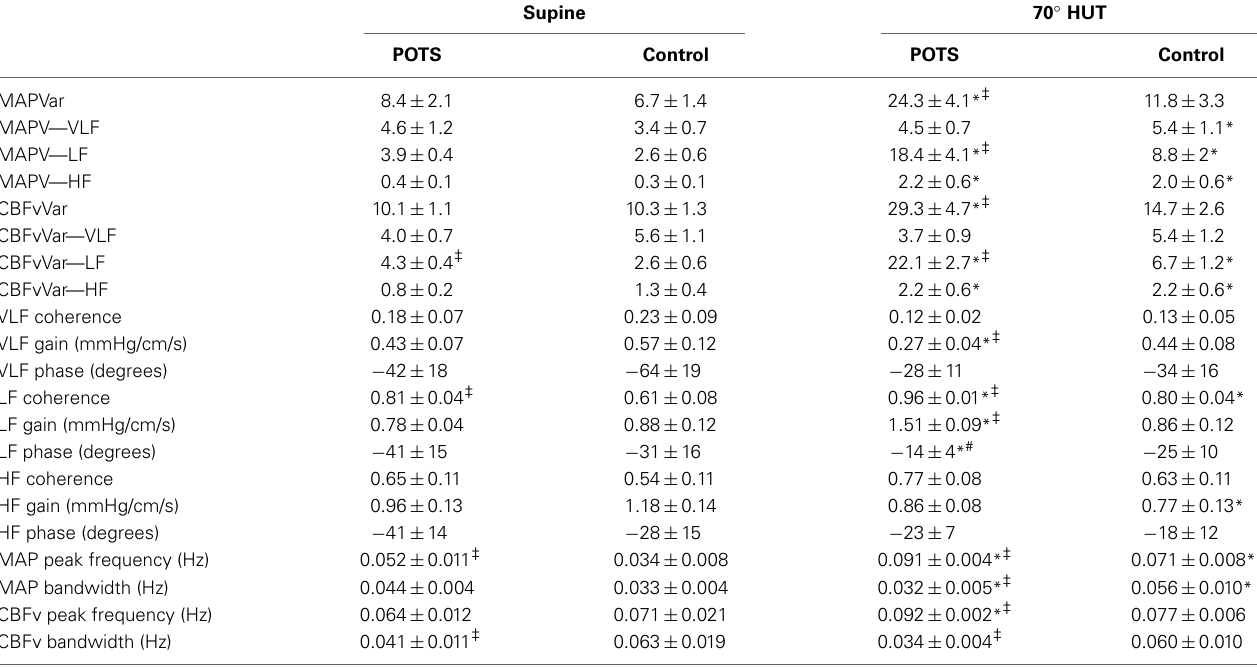
Table 2 | Mean arterial pressure → Cerebral blood flow velocity transfer function analysis and autospectral peaks and bandwidths in control subjects and POTS patients measured Supine and during 70 ◦ head-up